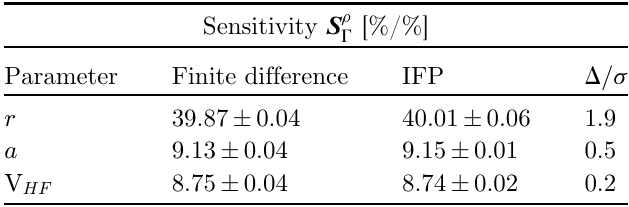
Table 2. Sensitivities to the fi rst 239 Pu positive-energy resonance parameters for the PST001 benchmark [14].